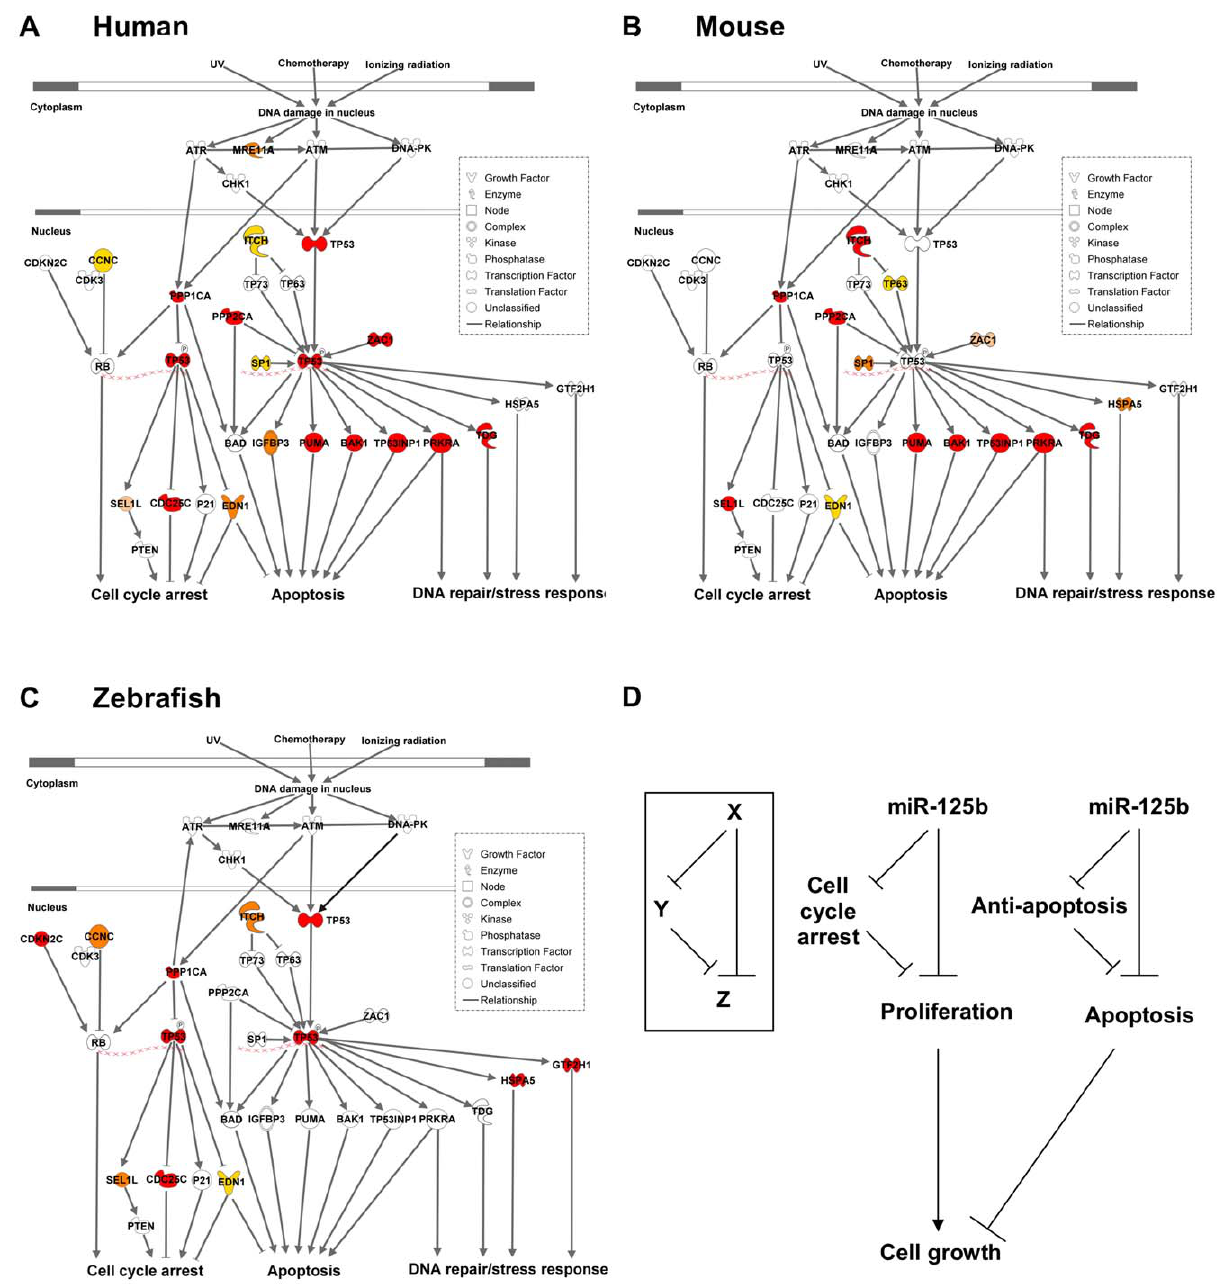
Figure 6. Models of miR-125b regulation of p53 networks in humans, mice, and zebrafish. (A) Human p53 network. (B) Mouse p53 network. (C) Zebrafish p53 network. Models were constructed by Ingenuity Pathway Analysis. Red: predicted targets validated by 3 assays; Orange: predicted targets validated by 2 assays; Yellow: predicted targets validated by 1 assay; Pink: predicted targets not validated by any assay, but validated by 3 assays in another species. (D) Incoherent feedforward loop (FFL) motifs characterize miR-125b regulation of p53 network genes that mediate apoptosis or cell cycle arrest.